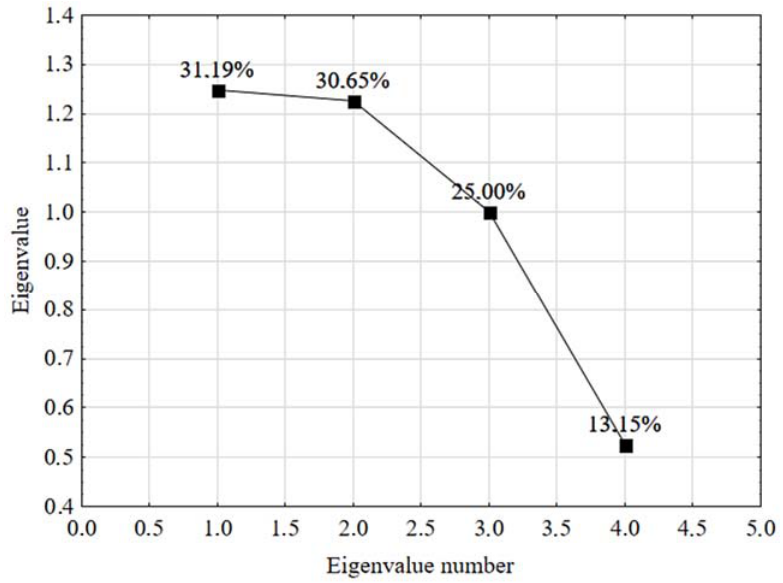
Figure 5. Scree plot graph of the percentage of explained variance of the main components for the efficiency of the water ultrasound treatment using the bench ‐ scale prototype.